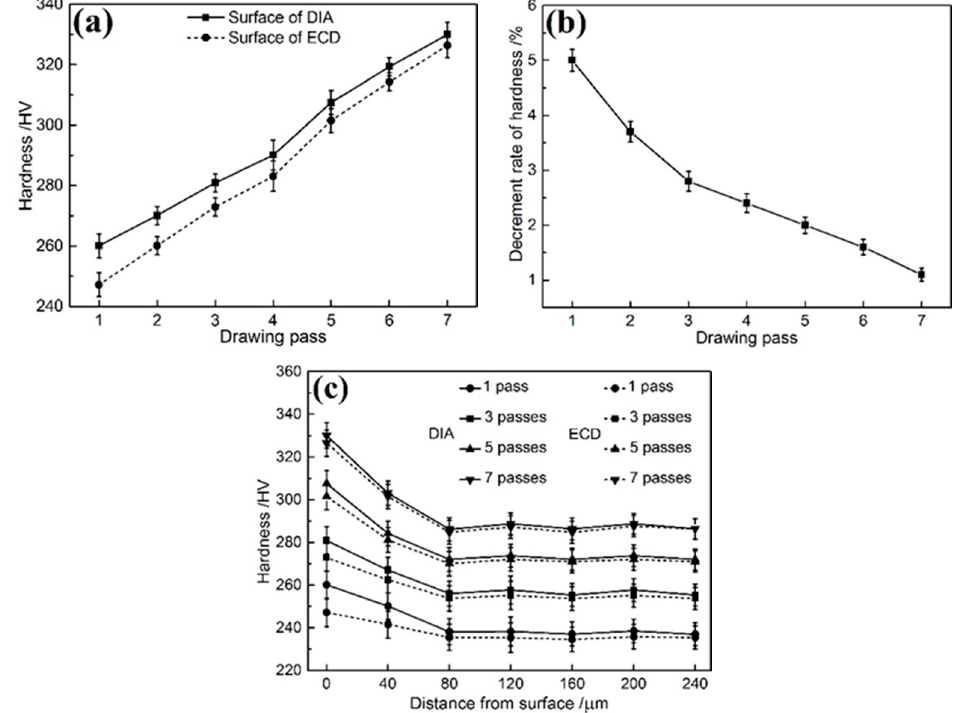
Figure 8. Variations in ( a ) surface hardness of the ECD and DIA bars, ( b ) decrement rate of the surface hardness of the ECD bar compared with DIA bar with drawing pass, and ( c ) cross section hardness of the ECD and DIA bars processed for different passes with the distance away from surface.